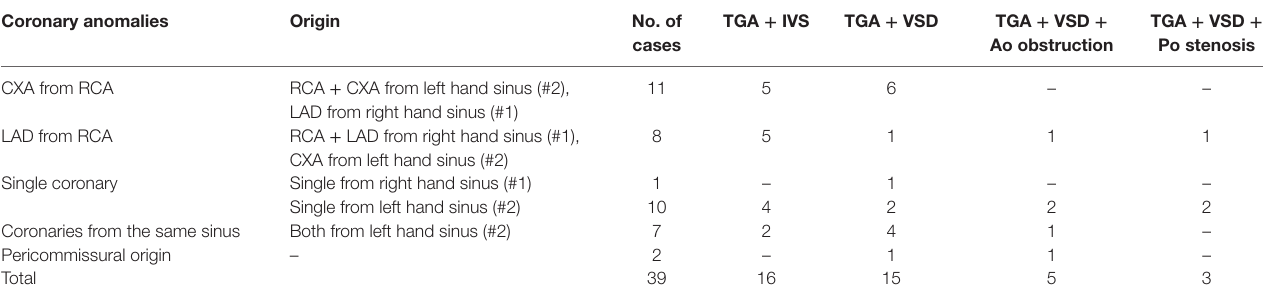
TaBle 7 | complete Tga: coronary anomalies.